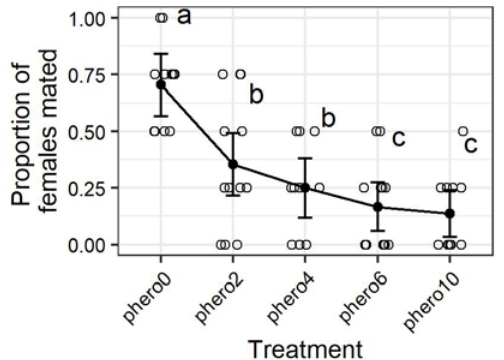
Figure 3. Females mated in 208 L chambers by mating disruption treatment (see Figure 1). Treatments phero0, phero2, phero4 ... etc. indicate the amount of time males were exposed to a pheromone mating disruption dispesnser; e.g., 2, 4, or 6 hours. Open circles represent individual observations, and the black points and whiskers respectively represent the mean and standard error. Means with different letters are significantly different ( p < 0.05, GLM (generalized linear model) with binomial distribution).